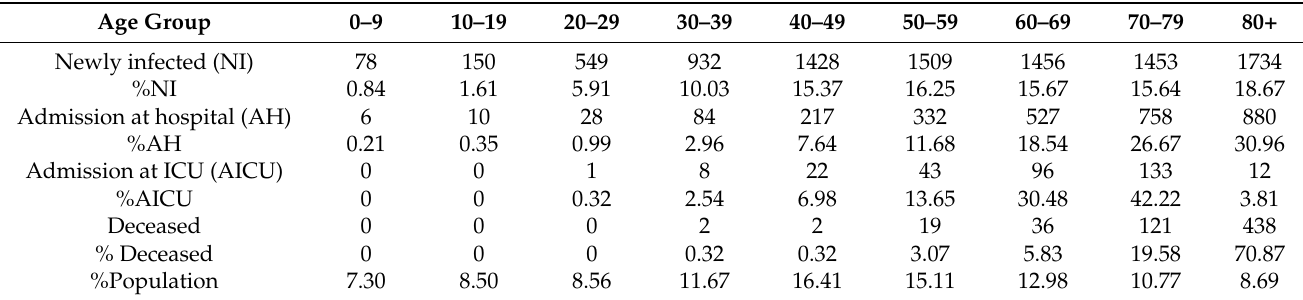
Table 2. Data corresponding to the first wave—4 March 2020 to mid-June 2020.